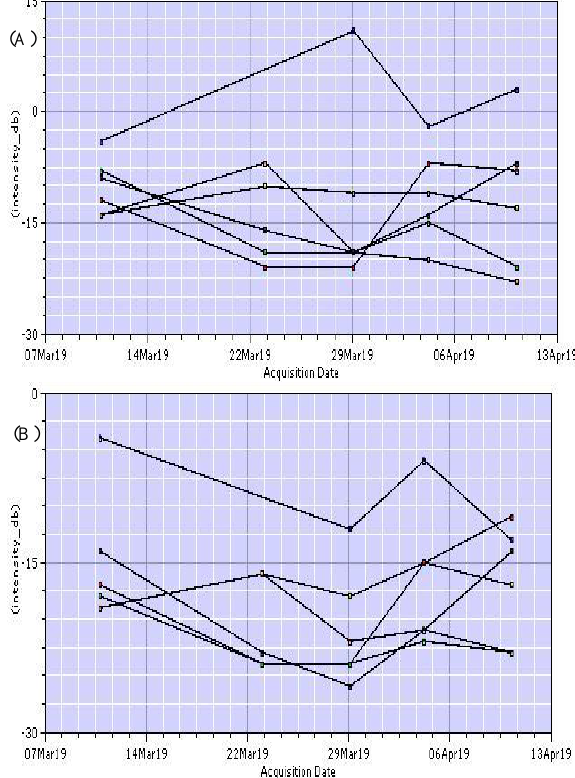
Figure 4. Time Series Pixel Value Reflectance in dB, (A) Reflectance of Pixels in VV band, (B) Reflectance of Pixels in VH band According to Fig.